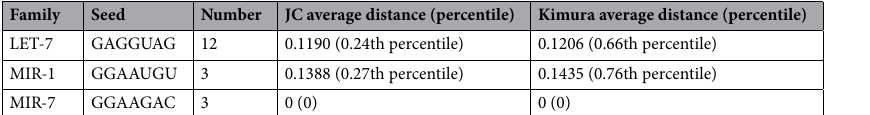
Table 9. The distance of miRNAs in three seed